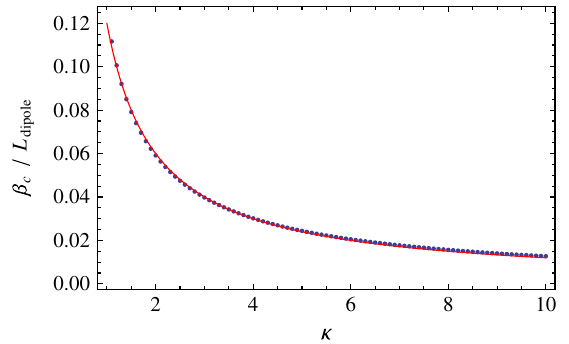
FIG. 4. The beta minimum over dipole length for the absolute minimum emittance. The red curve is given by the approximate ¼ 0 : 12 =(cid:12) . expression (cid:8)=L dipole